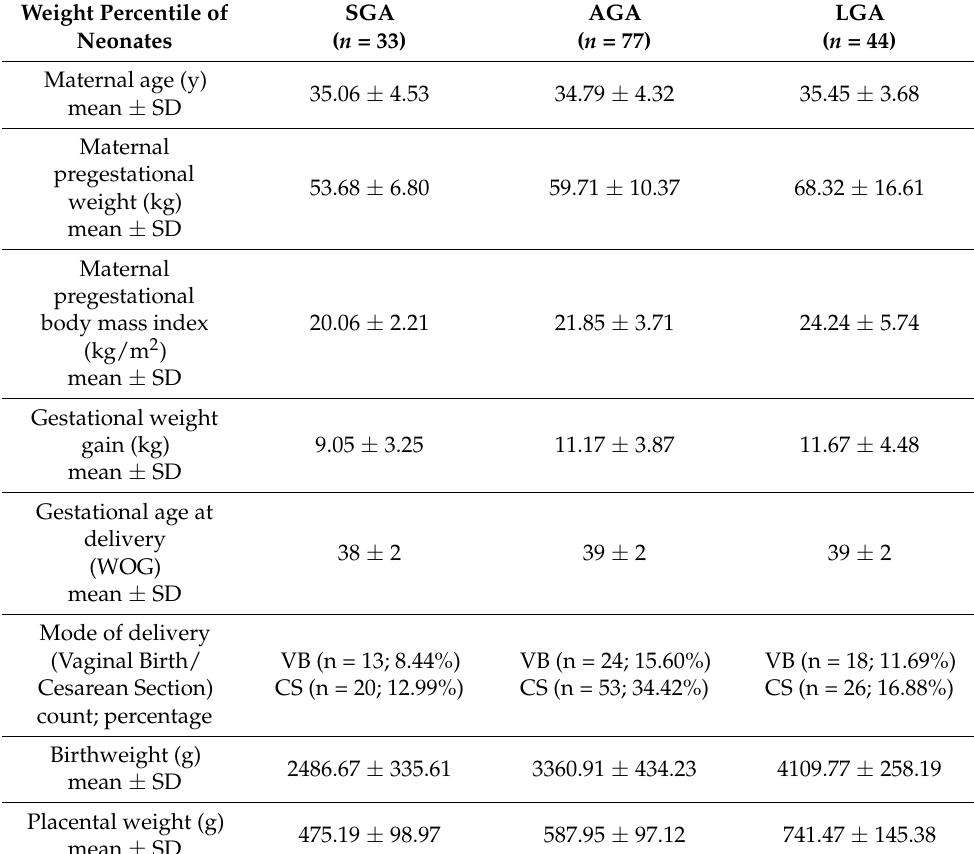
Table 1. Study population with the main clinical features of the